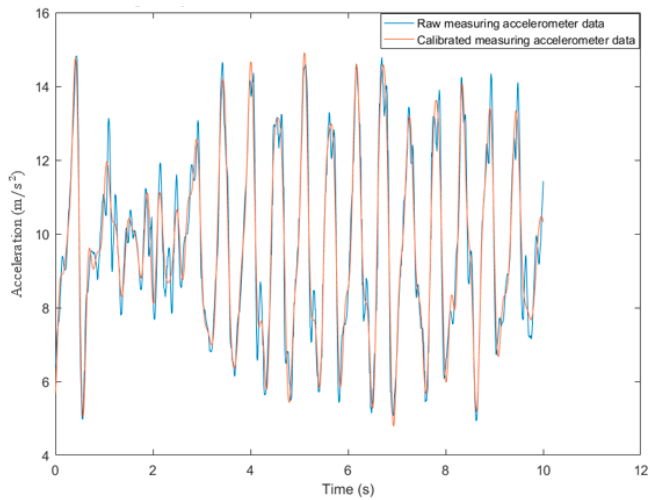
Figure 2. A low-pass filter for the acceleration signals with a cut-off frequency of 5 Hz to remove high-frequency noise.